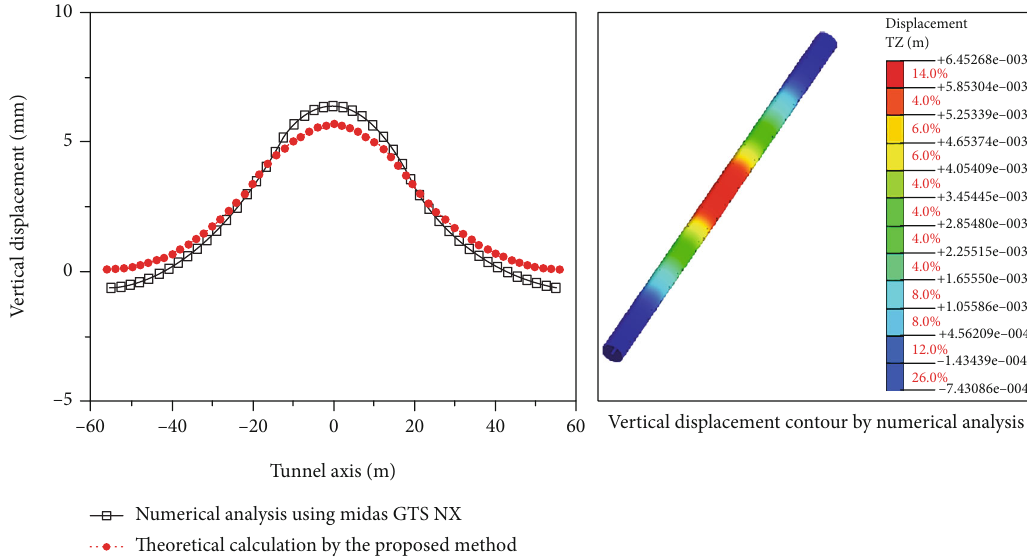
Figure 9: Excavation-induced tunnel vertical displacements by numerical and theoretical